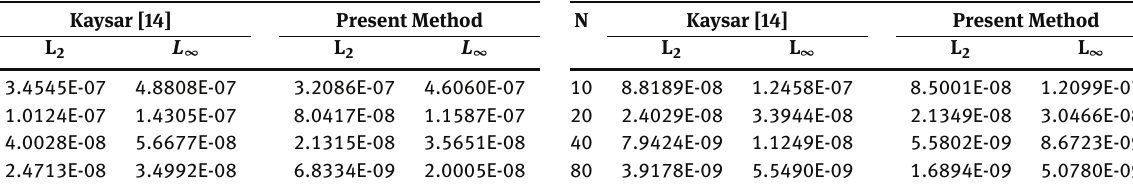
Table 12: Comparison of Errors in L 2 norm and L ∞ norm for